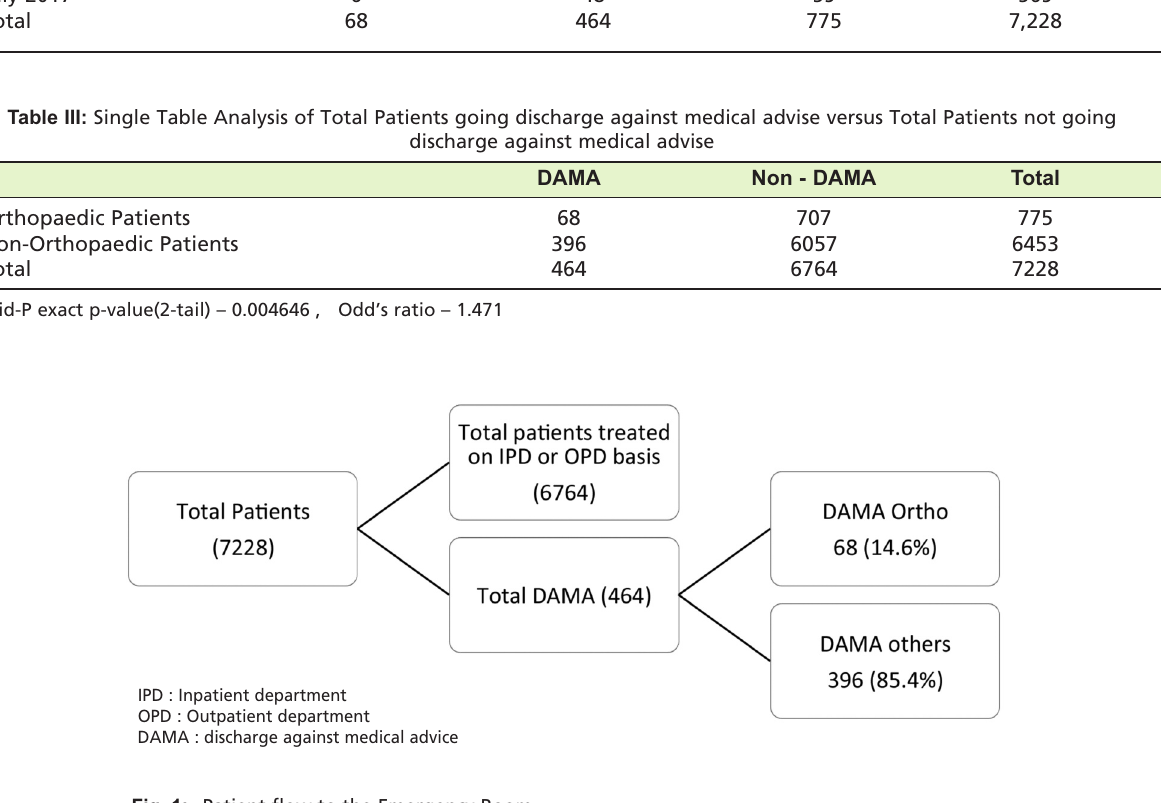
Patient flow to the Emergency Fig. 1: